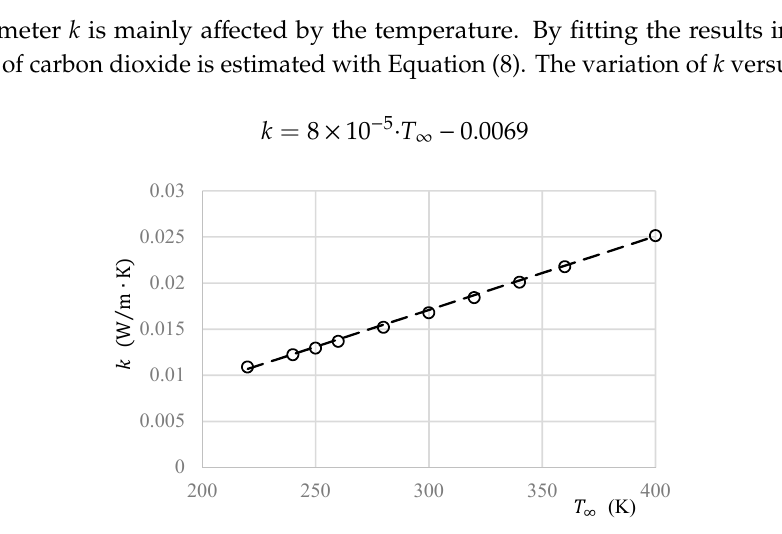
Figure 2. Variation of k versus T ∞ for the carbon dioxide. Hollow points: results in [36]; Dashed line: results from Equation (8).